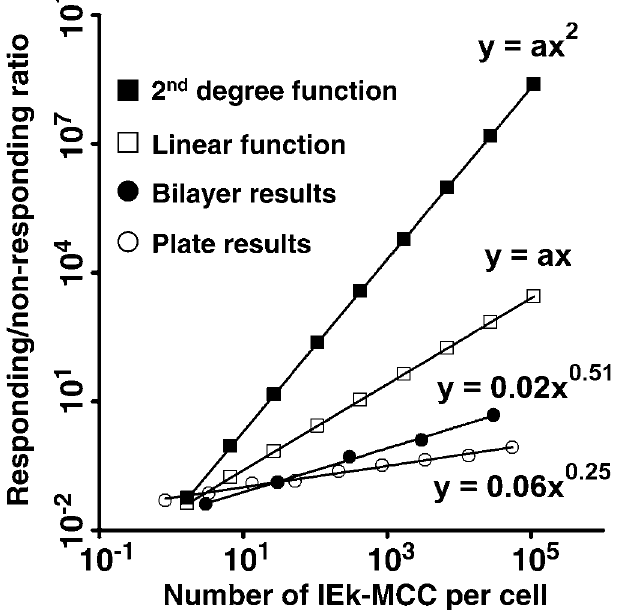
Figure 6. T Cells Respond to Agonist pMHC in a Sublinear Fashion AD10 T cell calcium responses to IEk-MCC diluted by IEk-HSP70 on lipid bilayers in Figure 2B and AD10 T cell IL2 responses to bio-IEk-MCC on streptavidin plates in Figure 3A are plotted as power functions of the calculated number of IEk-MCC per cell. T cell responses are shown as the ratio of responding to nonresponding cells. Also shown are theoretical curves of linear and second-degree function responses.